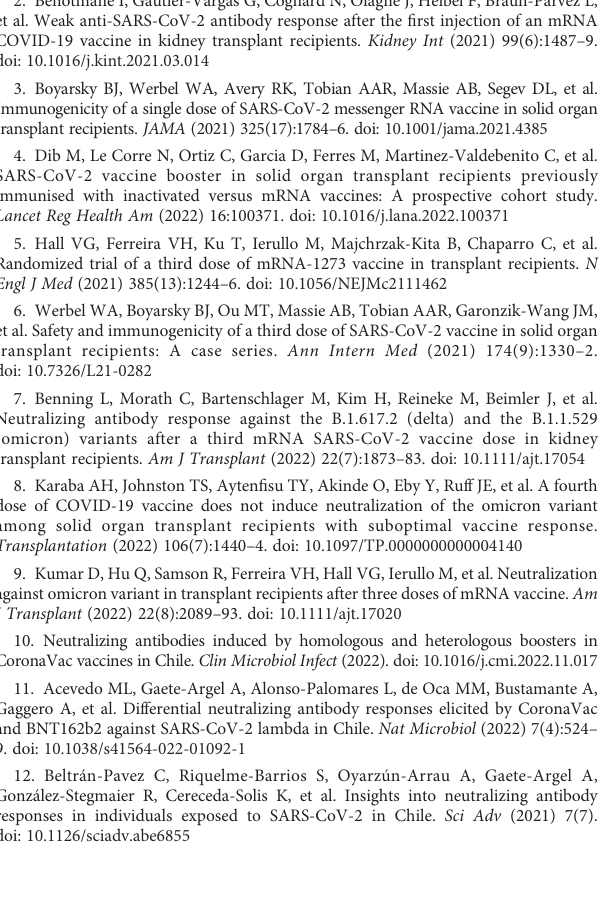
booster (AH-AS) of each sample are shown. Excluded samples tested positive for anti-N antibodies are highlighted in yellow ( “ NA ” , non-applicable; “–” , no data; ND,